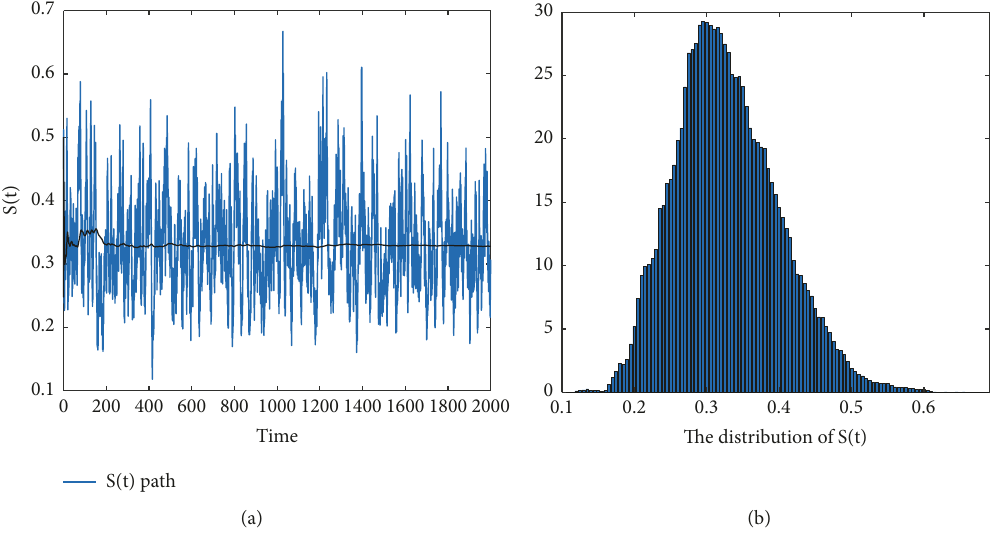
Figure 2: (a) is the time series of 𝑆(𝑡) with initial value 𝑆(0) = 0.5 ; (b) is the distribution interval of 𝑆(𝑡) .